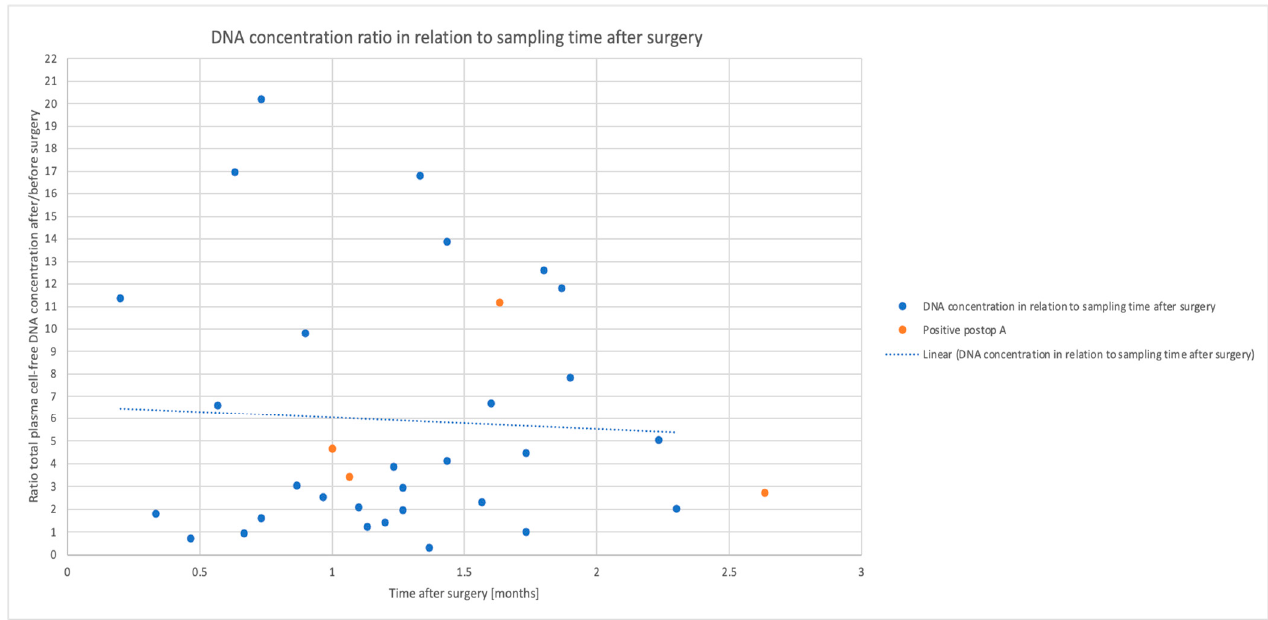
Figure 6. Cell-free DNA concentration ratio in relation to the sampling time after surgery. The ratio between the diagnostic plasma sample total cell-free DNA concentration and the concentration within 3 months after surgery is shown on the y -axis, with time after surgery on the x -axis. The blue horizontal line represents ratio 1, i.e., no difference in concentration. Most samples had an increased total cell-free DNA concentration (above ratio 1 on the y axis) between the two samples. Positive postop A, ctDNA detected after surgery by the bioinformatic approach A (tumour-informed).